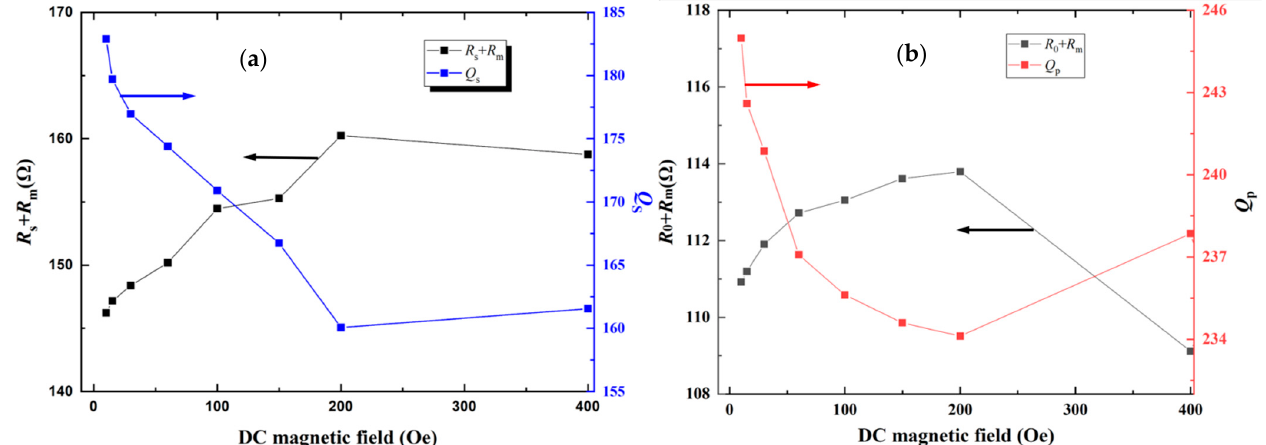
Figure 7. ( a ) The Q s and R s + R m of the ME sensor as a function of DC magnetic field; ( b ) The Q p and R 0 + R m of the ME sensor as a function of DC magnetic field. The maximum RSDs of Q s and Q p with multiple measurements are 0.22% and 0.21%, respectively. The maximum RSDs of R s + R m and R 0 + R m with multiple measurements are 0.24% and 0.26%, respectively.